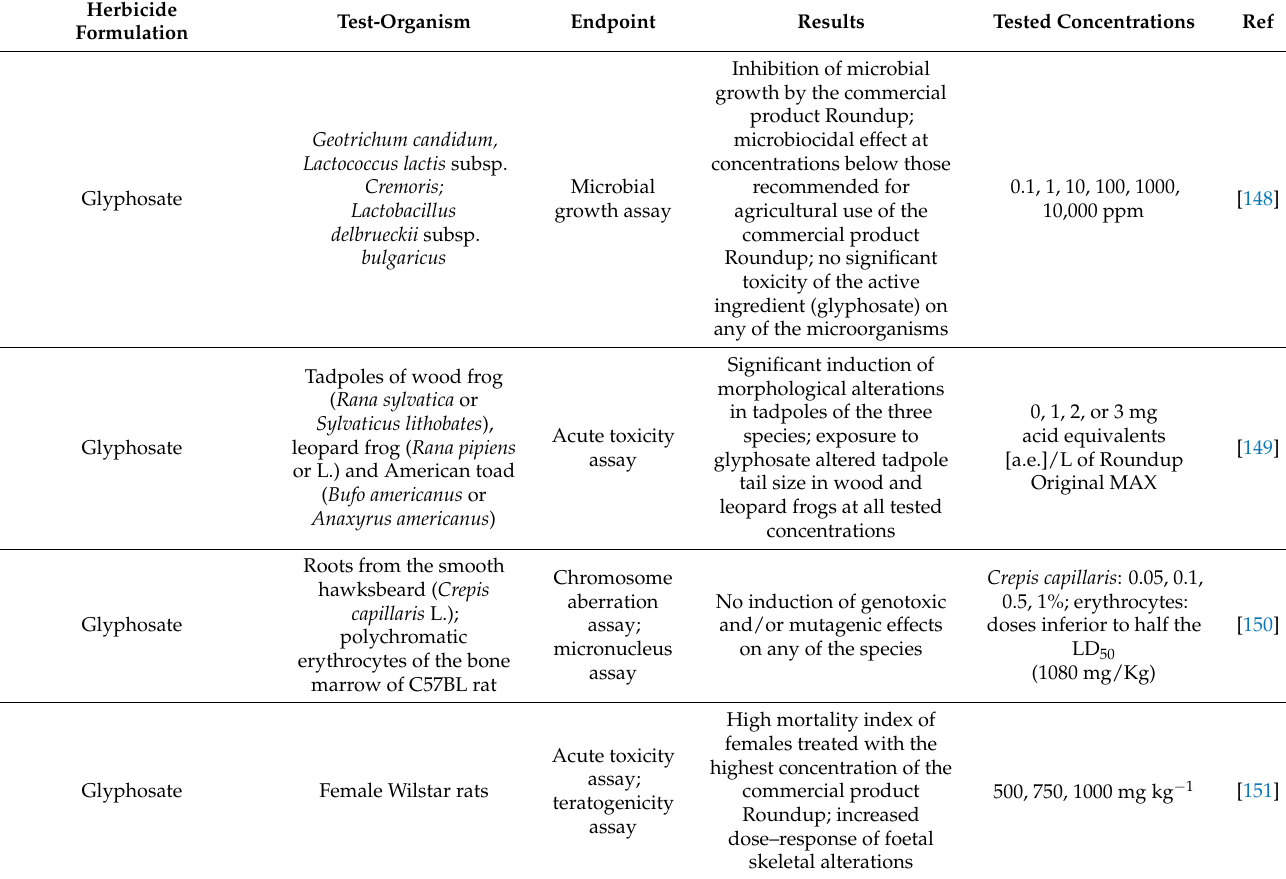
Table 3. Some recent studies of glyphosate-based formulations’ toxicity involving various indicators such as organisms that can be affected and the main results at tested concentrations. Herbicide Test-Organism Endpoint Results Tested Concentrations Formulation